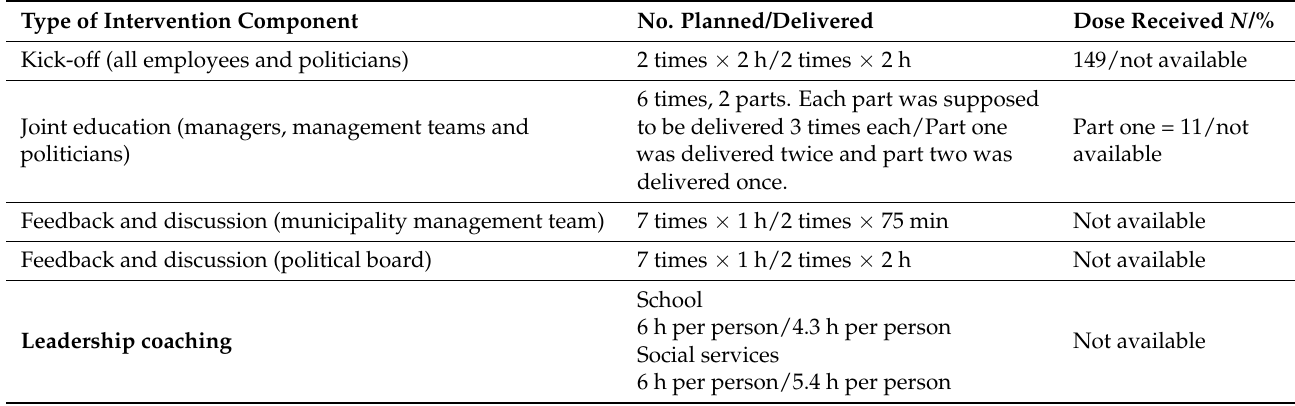
Table 5. Dose delivered (numbers planned/delivered) and dose received (N/%) for all intervention components. Type of Intervention Component No.